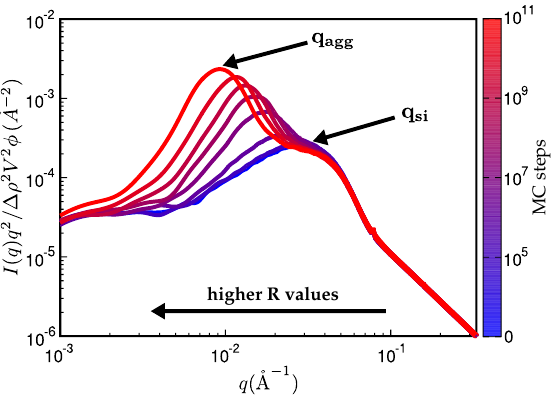
Figure 9. Kratky representation of the scattering intensity vs. q for different number of MC steps. An increasing number of MC steps shifts the aggregate peak at q agg to smaller q values, resulting in growing aggregates. The particle peak at q si remains at its position. The polymer is carboxylated acrylonitrile-butadiene rubber (XNBR, Lanxess Krynac X740, γ d p = 17.1 mJ/m 2 and γ p p = 33.3 mJ/m 2 ) and the filler fumed silica (Aerosil 200, Degussa, γ d p = 20.0 mJ/m 2 and γ p p = 17.3 mJ/m 2 ). Filler volume content is φ = 25% and the temperature again T = 160 ◦